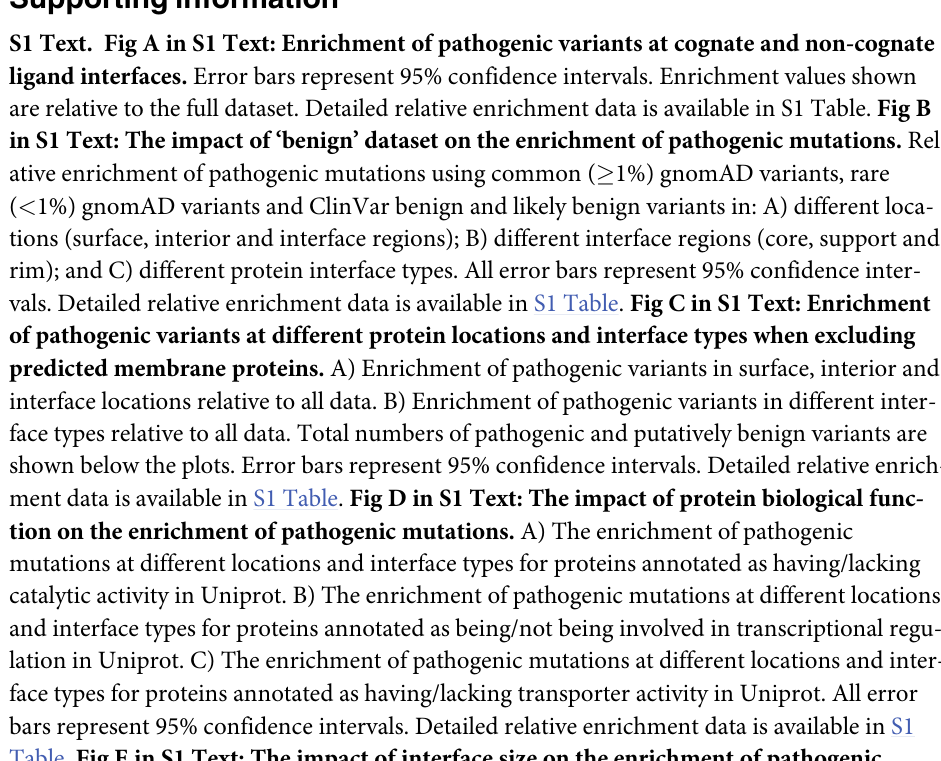
Table. Fig E in S1 Text: The impact of interface size on the enrichment of